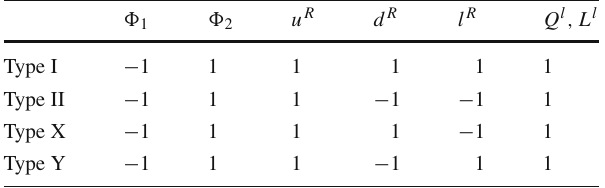
Table 1 Z 2 charge assignments of Higgs doublets and fermion fields for different 2HDM